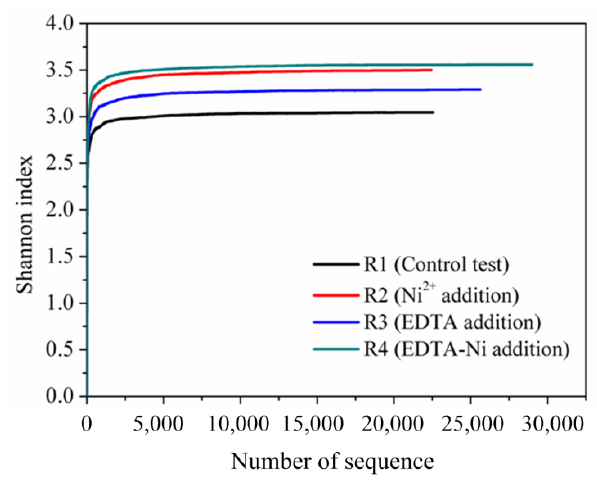
Figure 5. Shannon index of the methanogenic community in R1 – R4 on the 25th day.